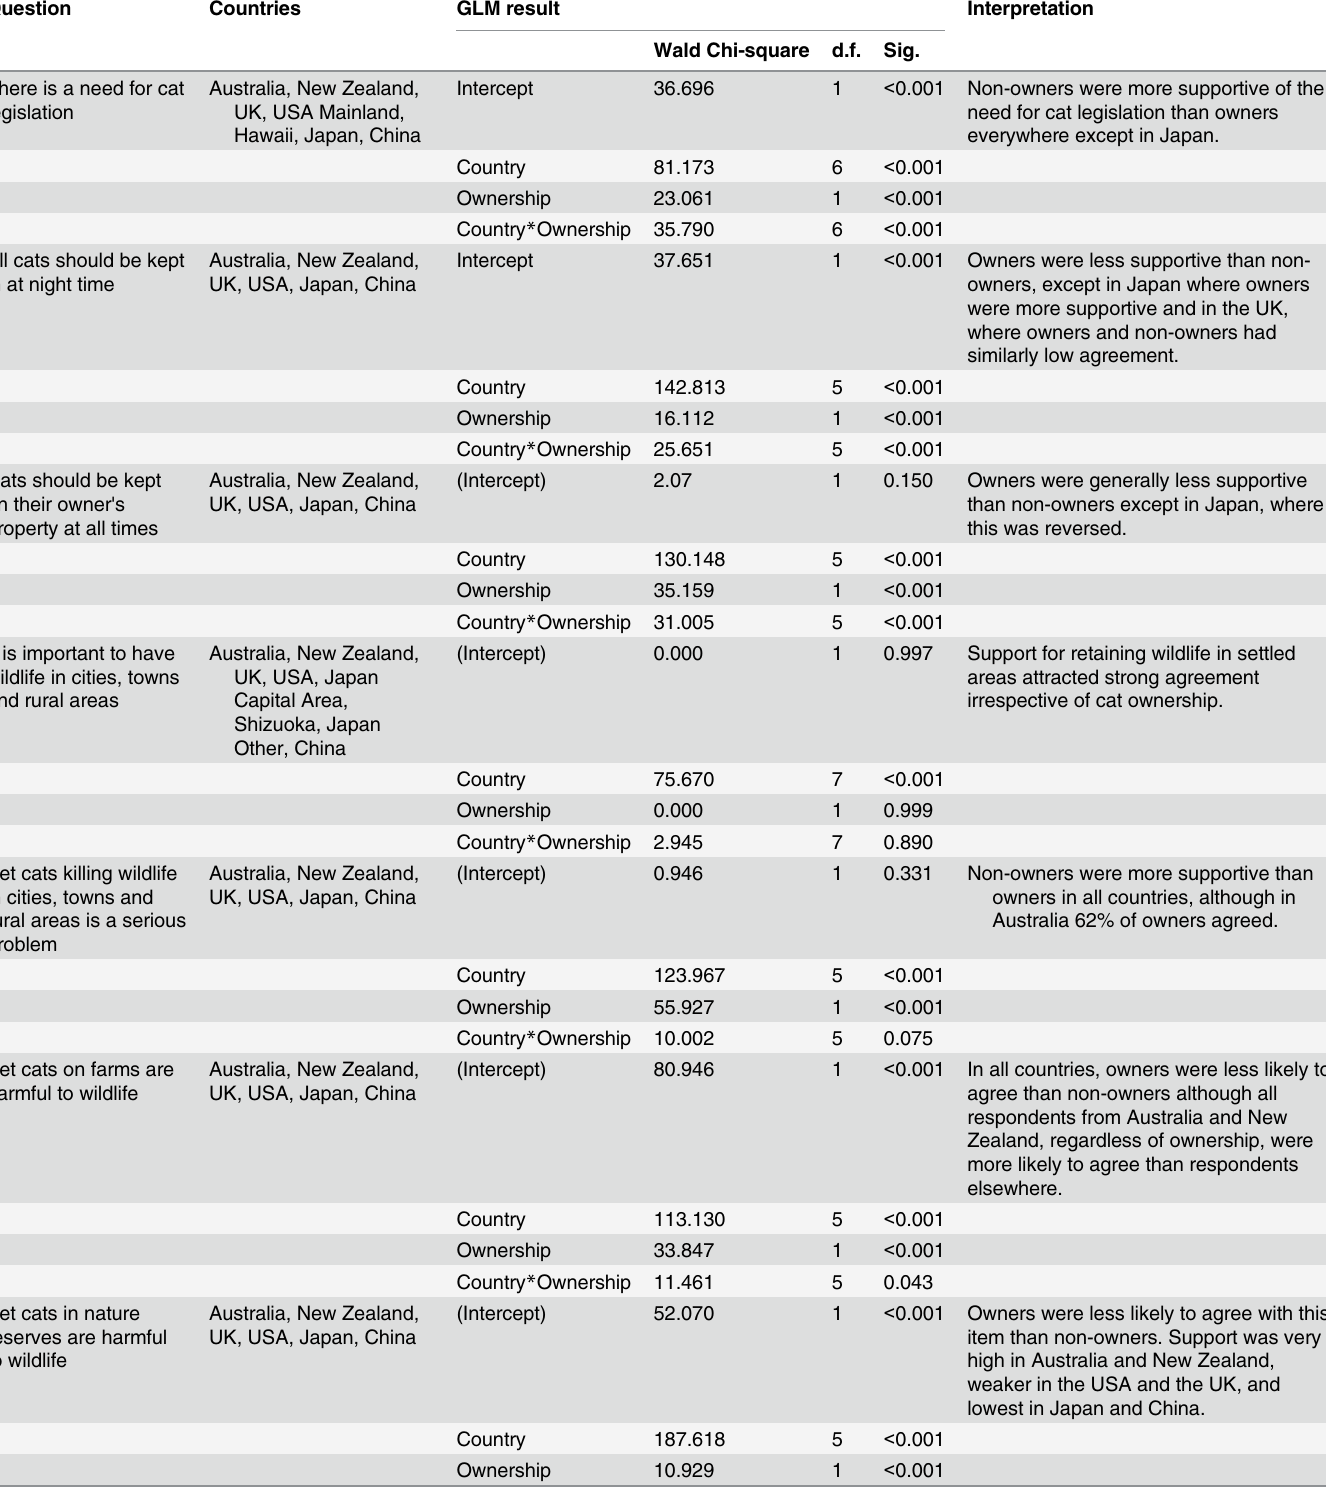
Table 3. Results of analysis of specific survey questions. Cities within countries are combined, unless responses were shown to differ between